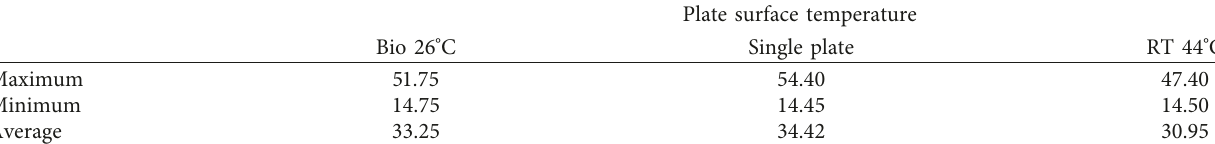
Table 4: Plate surface temperature measurements of Test 1 ( ° C).